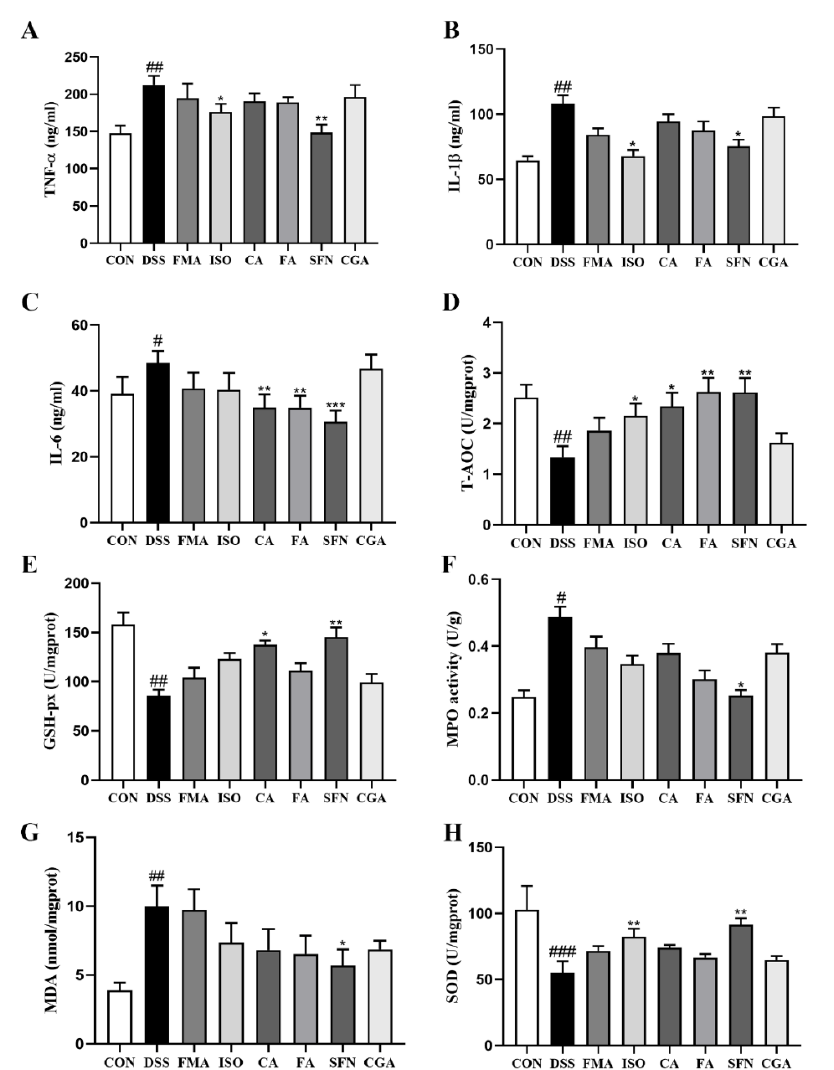
Figure 6. Effect of FECs on inflammatory and oxidative factors in colon tissue of mice with colitis. ( A ) TNF- α; ( B ) IL- 1β; ( C ) IL-6; ( D ) T-AOC; ( E ) GSH-px; ( F ) MPO; ( G ) MDA; ( H ) SOD. Data are expressed as mean ± SD ( n = 8). # p < 0.05, ## p < 0.01, ### p < 0.001 compared with the CON group; * p < 0.05, ** p < 0.01; *** p < 0.001, compared with the DSS group.